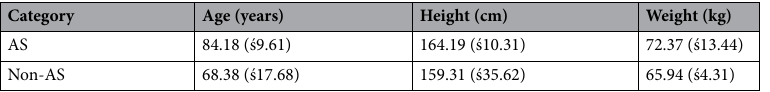
Table 1. Demographic information of subject groups (average ś standard deviation).